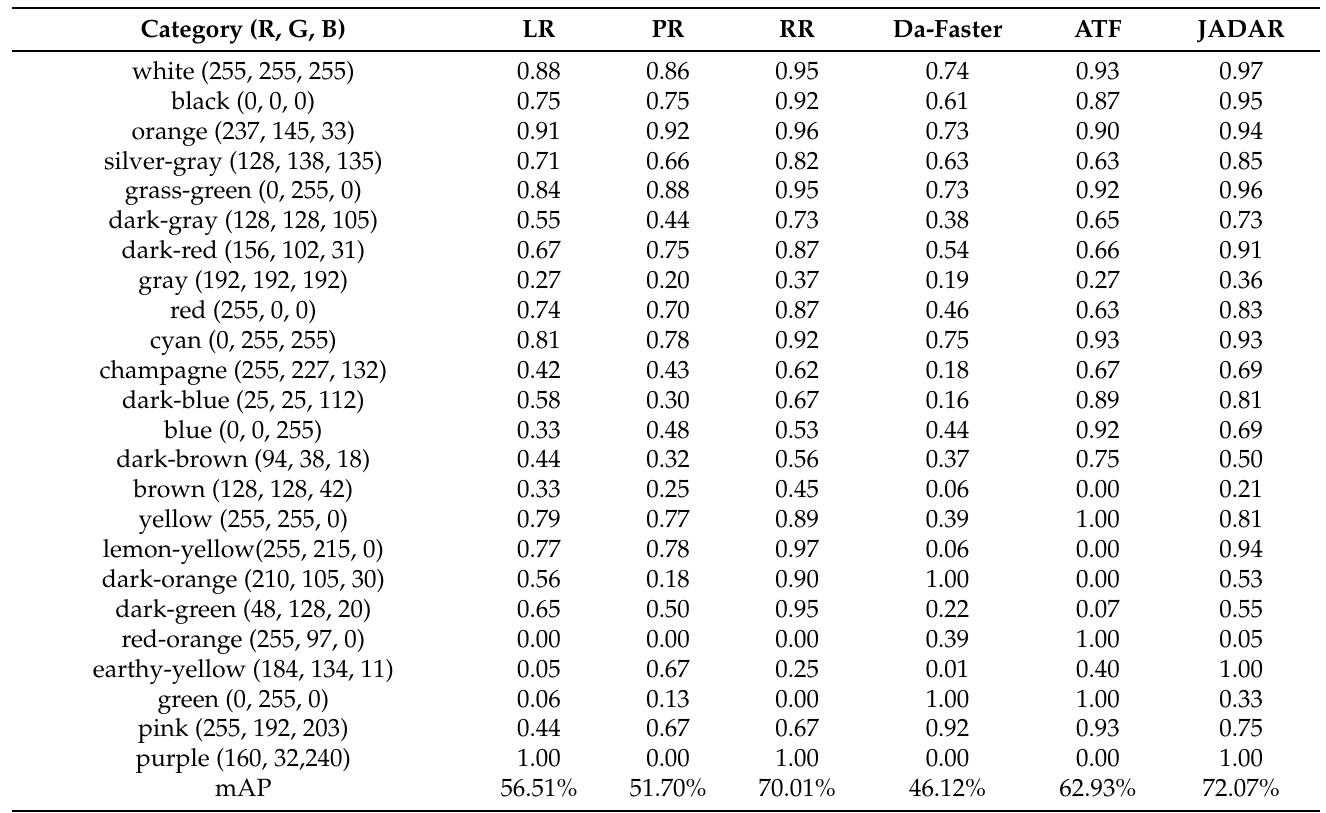
Table 3. Comparison of recognition accuracy of 24 colors for different network